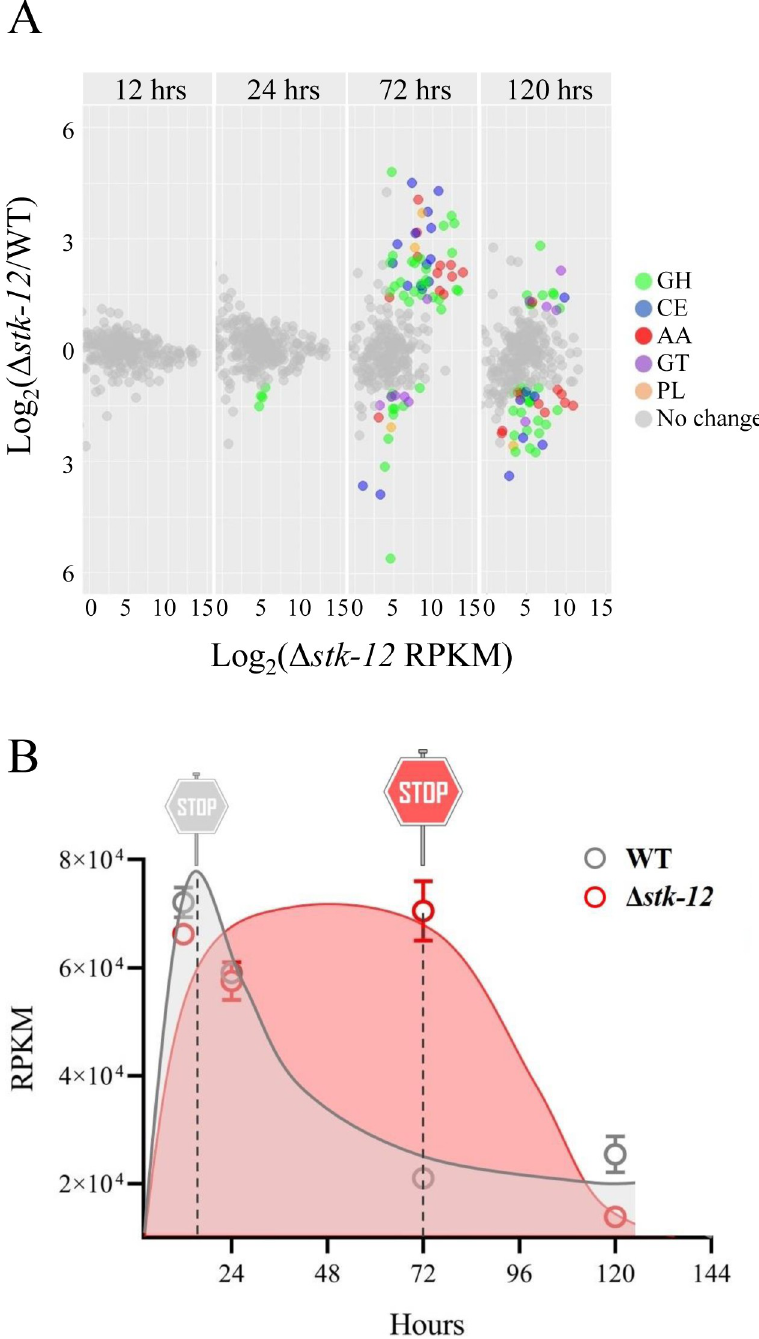
Fig 3. Transcriptional profiling revealing roles of stk-12 during growth on Avicel. (A) Relative mRNA abundance of all CAZy genes in Δ stk-12 vs. WT grown in Avicel medium. Genes with altered expression are plotted using different colors. Genes encoding glycoside hydrolases (GH, green ), carbohydrate esterases (CE, blue ), lytic polysaccharide monooxygenases (AA, red ), glycosyl transferases (GT, purple ), and polysaccharide lyases (PL, orange ). Gray points represent genes with no differences in transcript levels between WT and Δ stk-12 . (B) Expression levels of genes encoding cellulases in WT and Δ stk-12 mutant during culture, as determined from RNA-seq data.